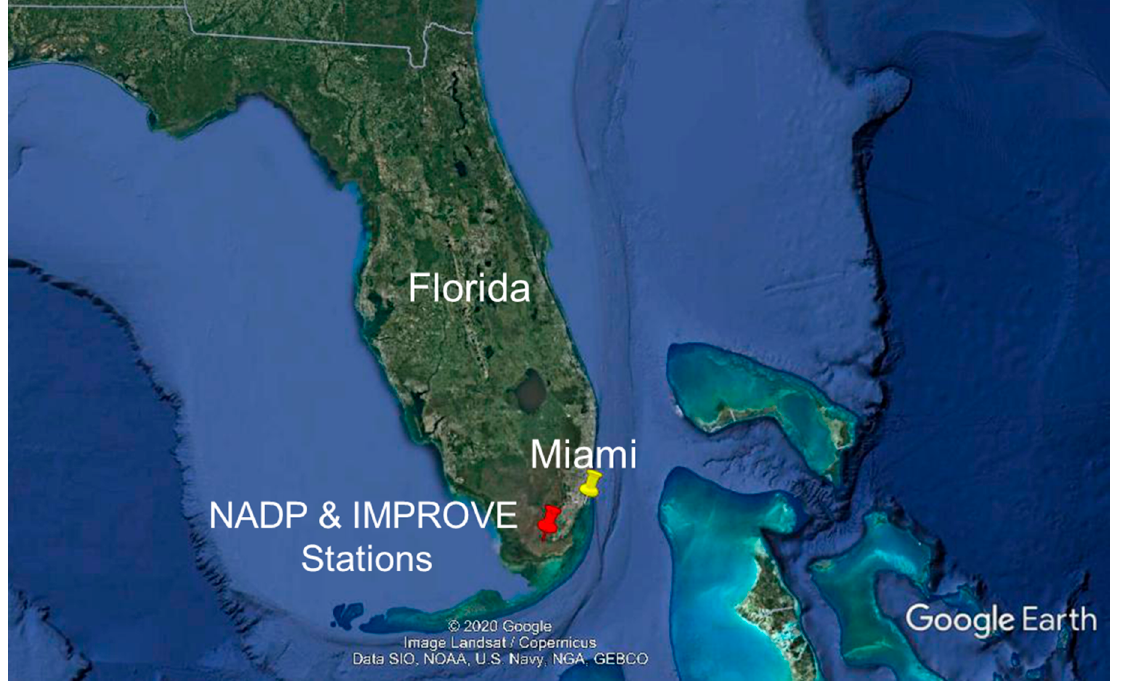
Figure 1. Map showing the location of Everglades National Park Interagency Monitoring of Protected Visual Environments (IMPROVE) and National Atmospheric Deposition Program (NADP) stations (red marker) in relation to Miami (yellow marker). Image source: Google Earth.